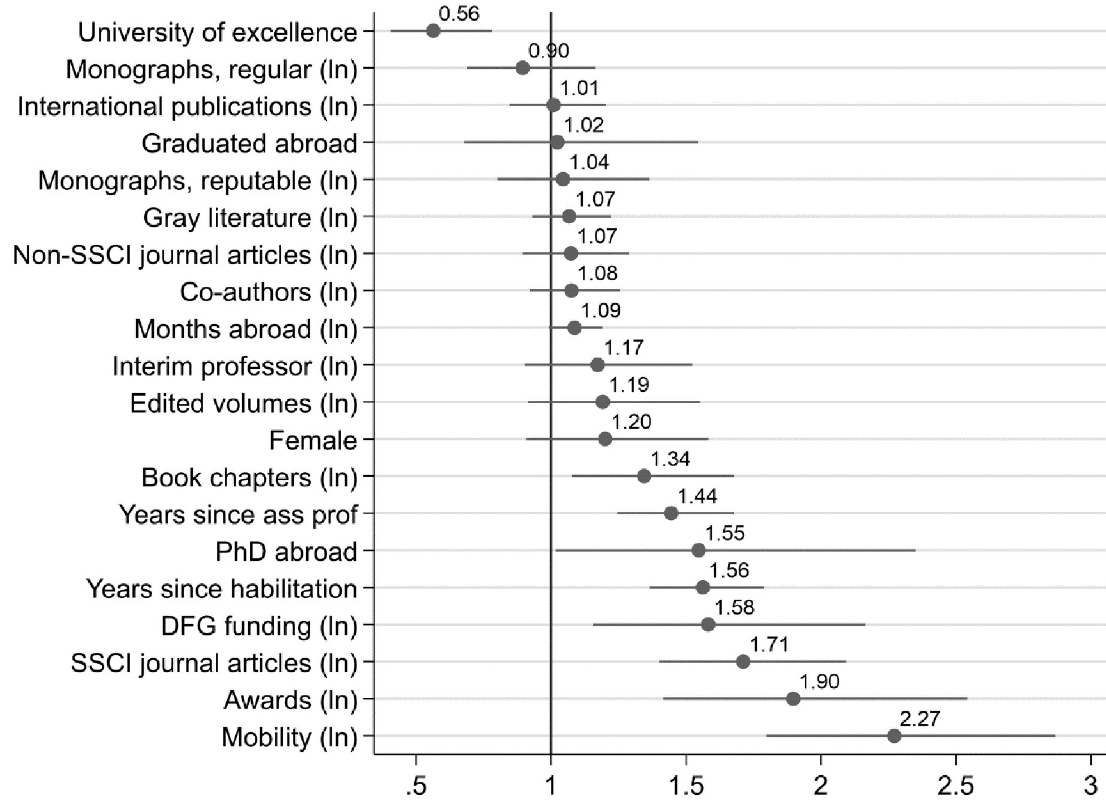
Fig 2. Effects on chance to get tenure, visualized results based on Model 4 in Table